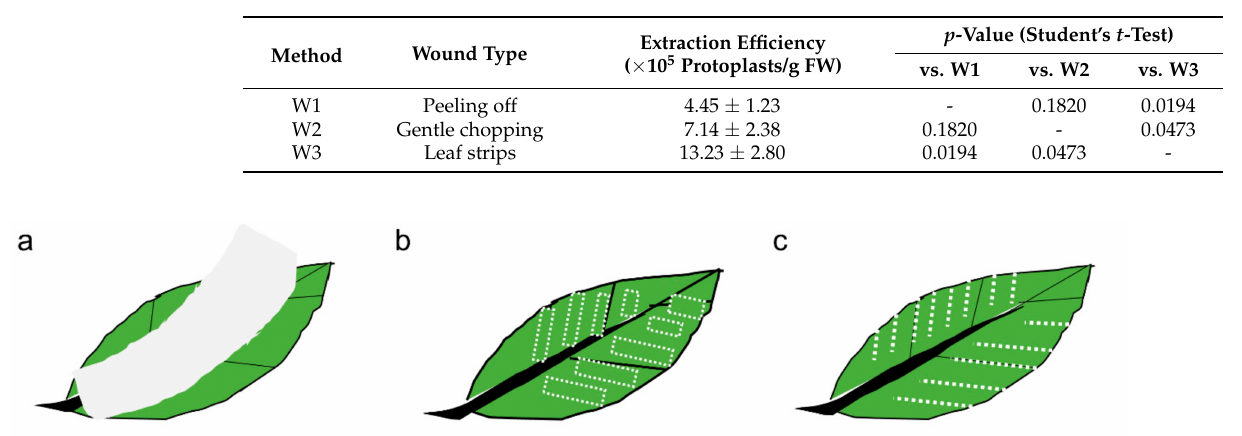
Table 1. Comparison of extraction efficiencies of protoplasts from leaves (1 g fresh weight) in response to three different wounding methods.